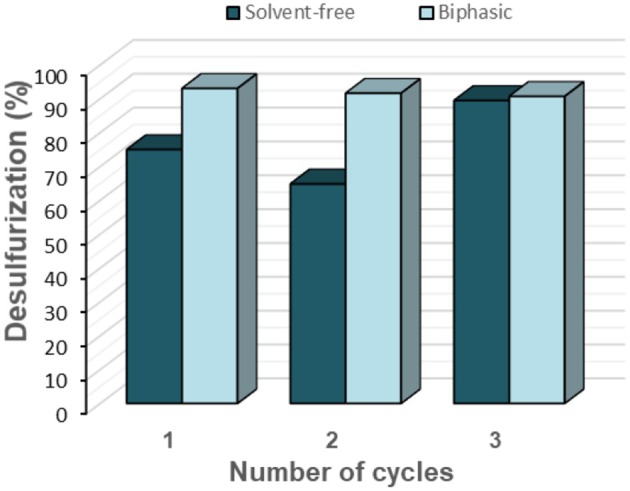
Desulfurization results of a real untreated diesel obtained after 2 h, catalyzed by PW11@TMA-SBA-15 at 70°C, using the solvent-free biphasic systems with H2O2/S = 8.